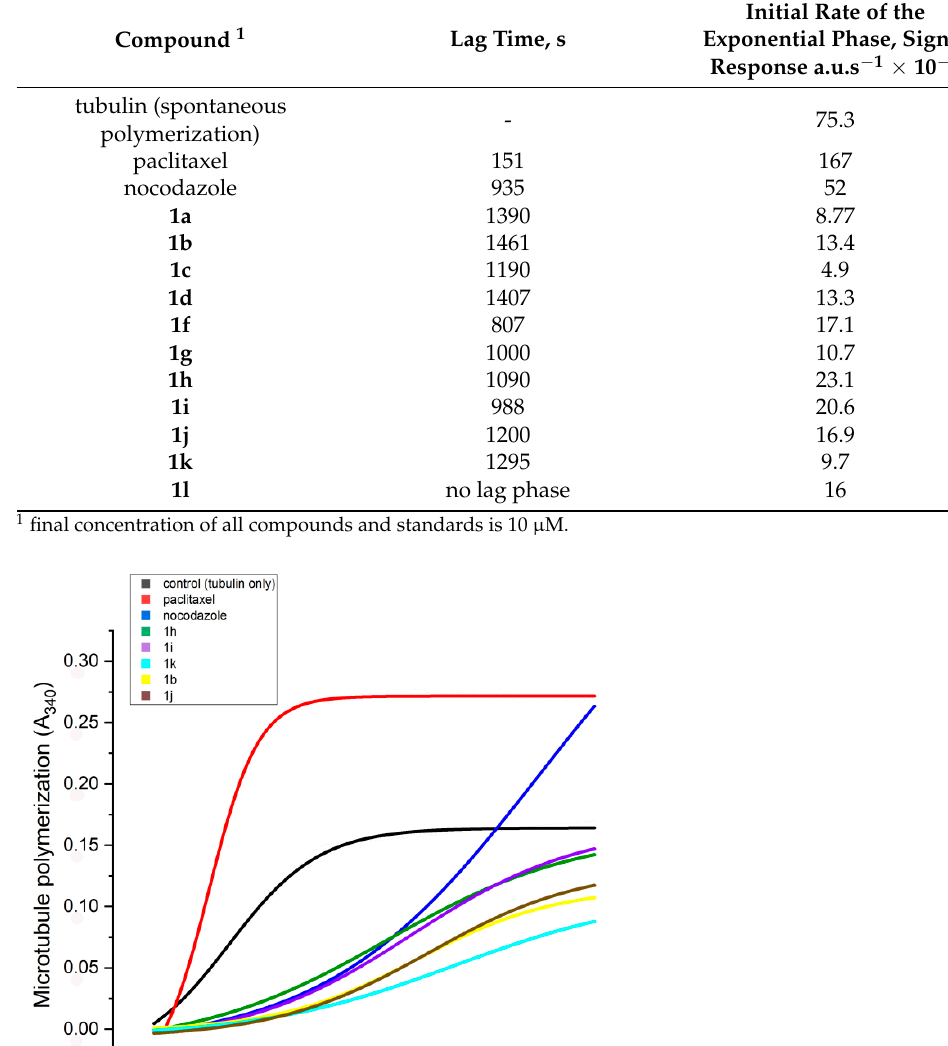
Table 1. In vitro effect on tubulin polymerization of 1 H -benzimidazole-2-yl hydrazones 1a–1 . Compound 1 Lag Time, s